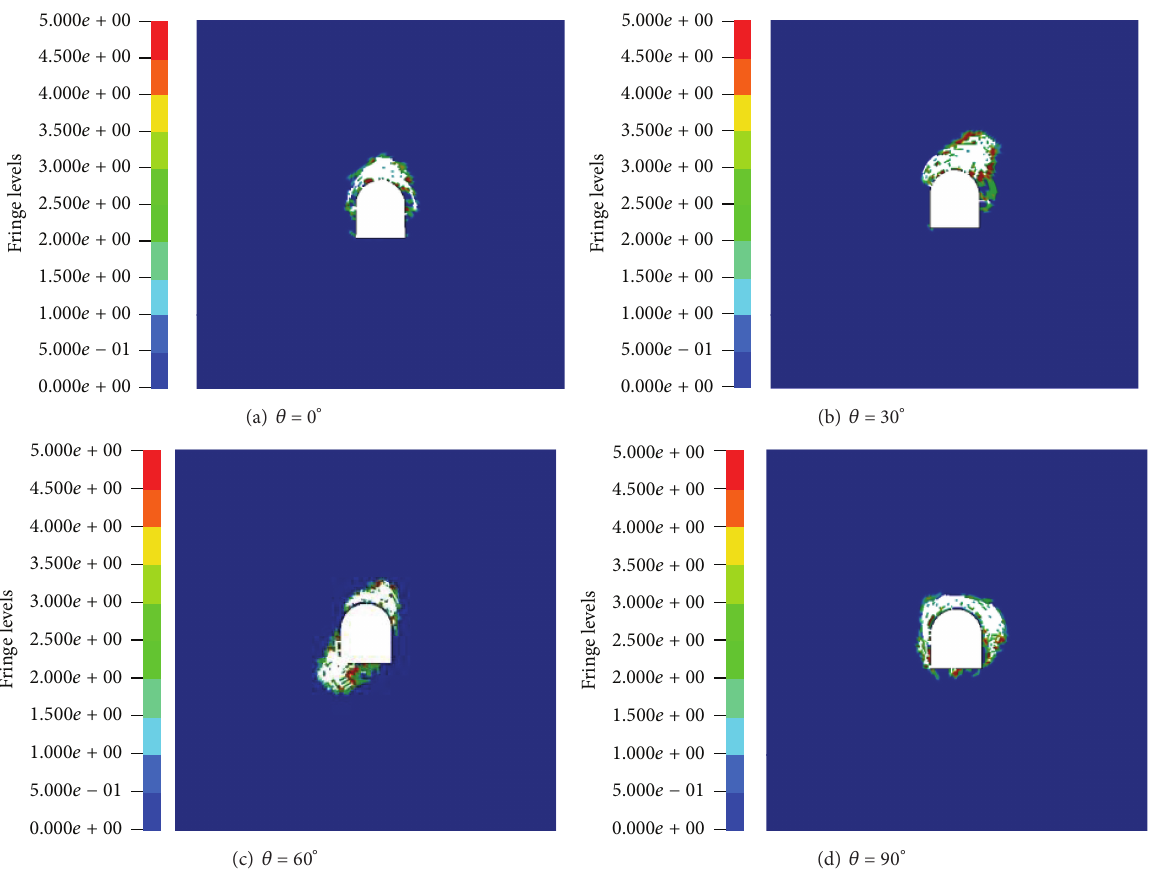
Figure 8: The plastic region and fracture pattern of the roadway under various geostress